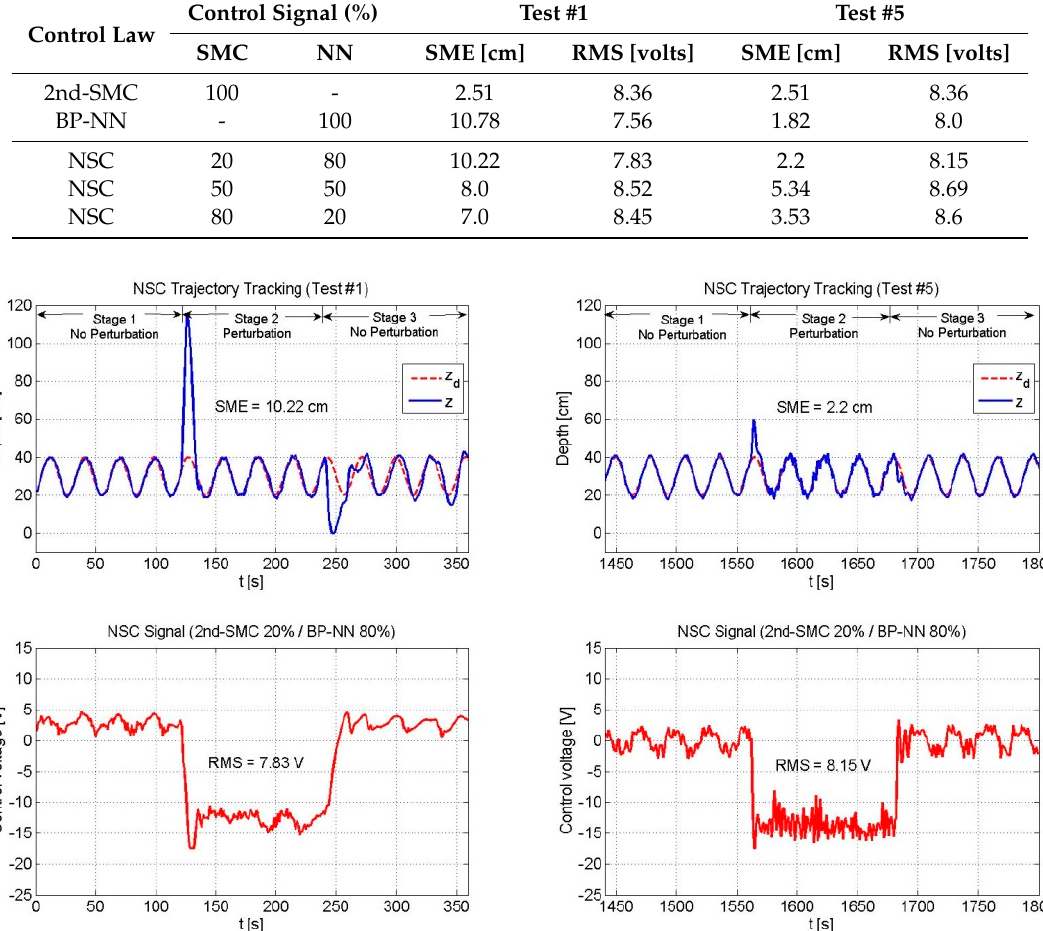
Figure 13. Performance of the NSC scheme (2nd-SMC 20%/BP-NN 80%).